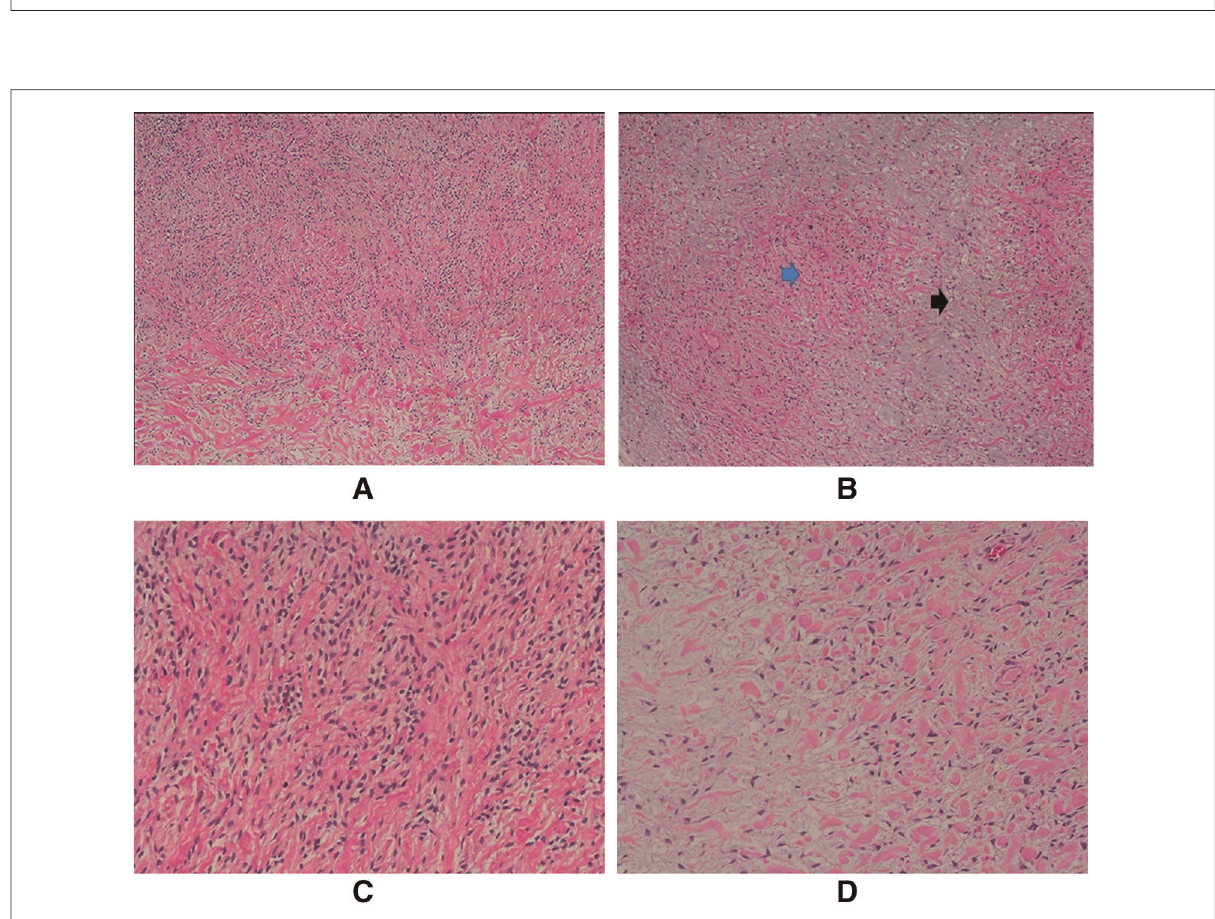
FIGURE 4 A . Mild to moderately cellular tumor (H&E, 4X); B . The biphasic growth pattern is demonstrated with both fi brous (blue arrow) and myxoid (black arrow) areas (H&E, 4X); C . The tumor cells are mostly bland oval to spindle-shaped (H&E, 10X) and stellate ( D ); (H&E,